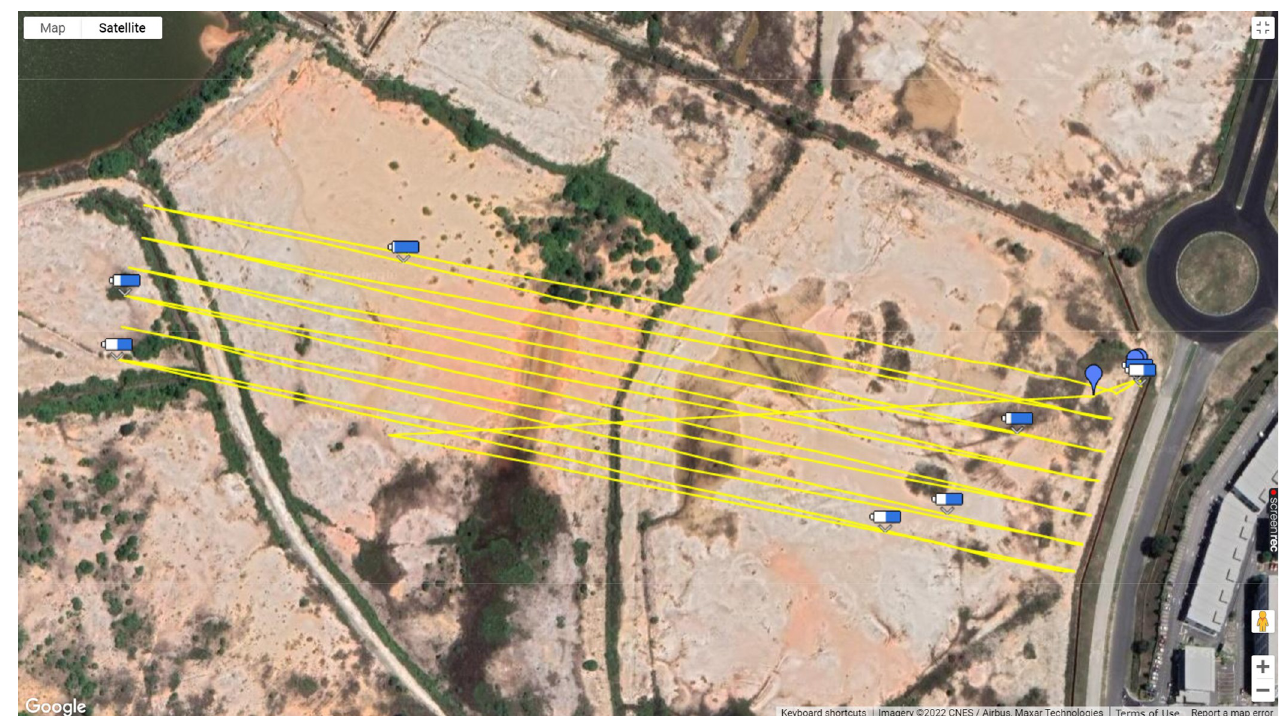
Fig 2. Drone flight path. Yellow lines illustrate the drone flight path used for all flights in this research.